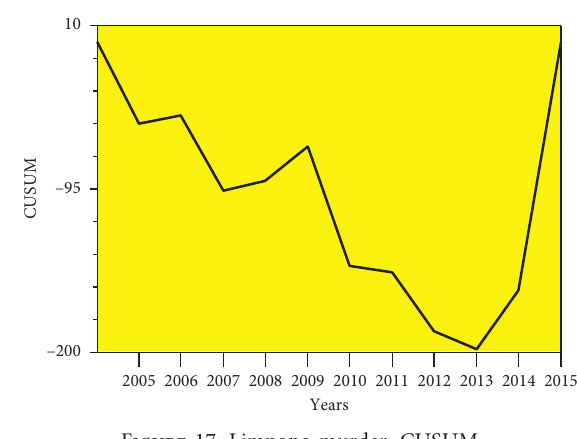
Figure 17: Limpopo murder: CUSUM